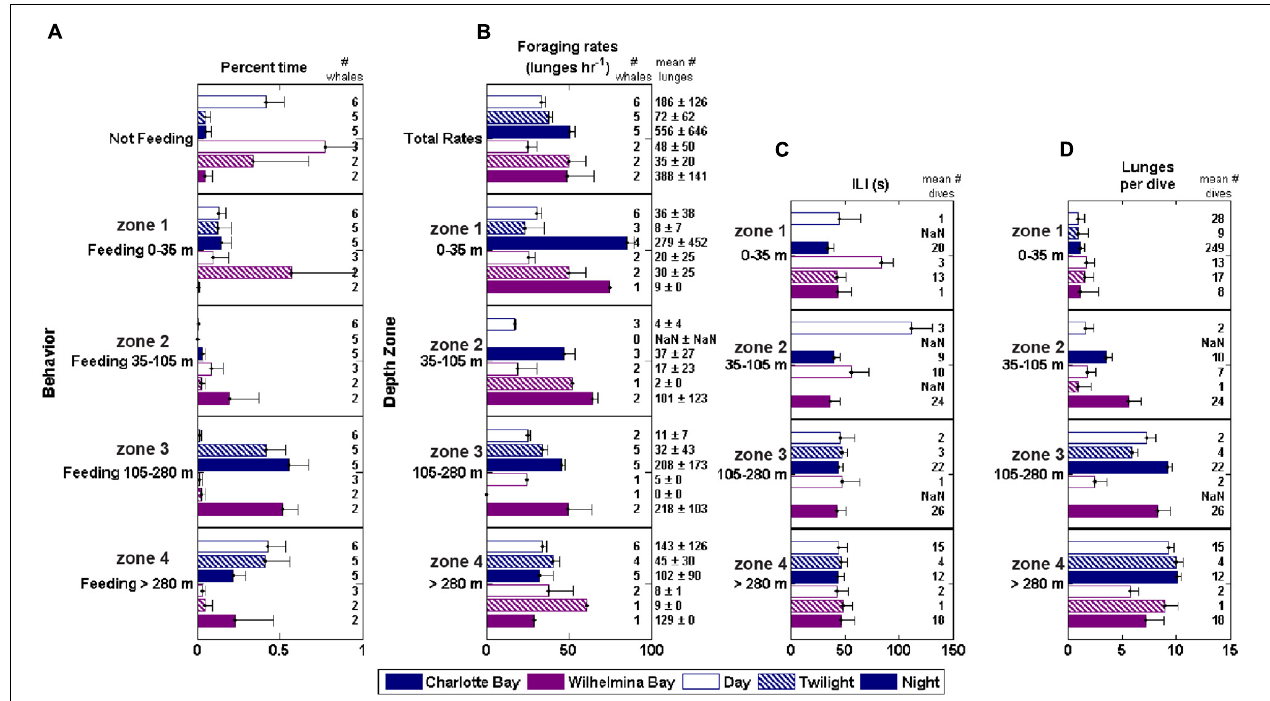
FIGURE 7 | Foraging behavior by depth zone, bay and diel period. ILI, inter-lunge-interval. Foraging rate is lunges/h while actively foraging (lunge rate within a defined feeding bout). (A) Percent time feeding in each zone. (B) Foraging rate in each zone. (C) Mean ILI in each zone (D) Mean lunges/dive in each zone.